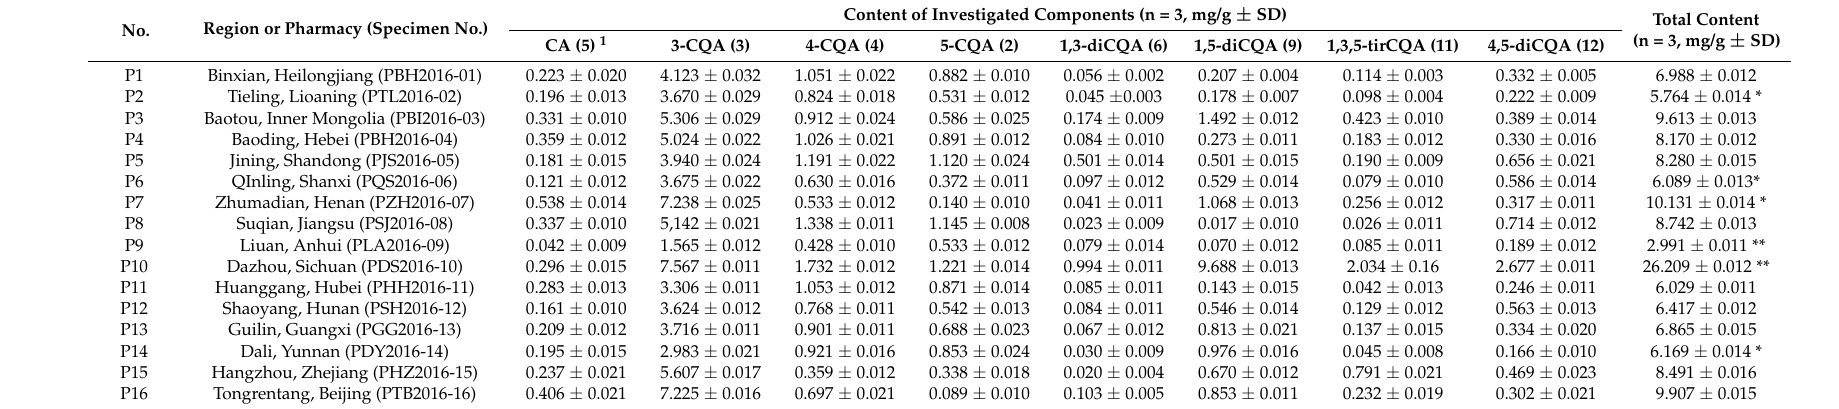
Table 3. Content of eight compounds in PXF